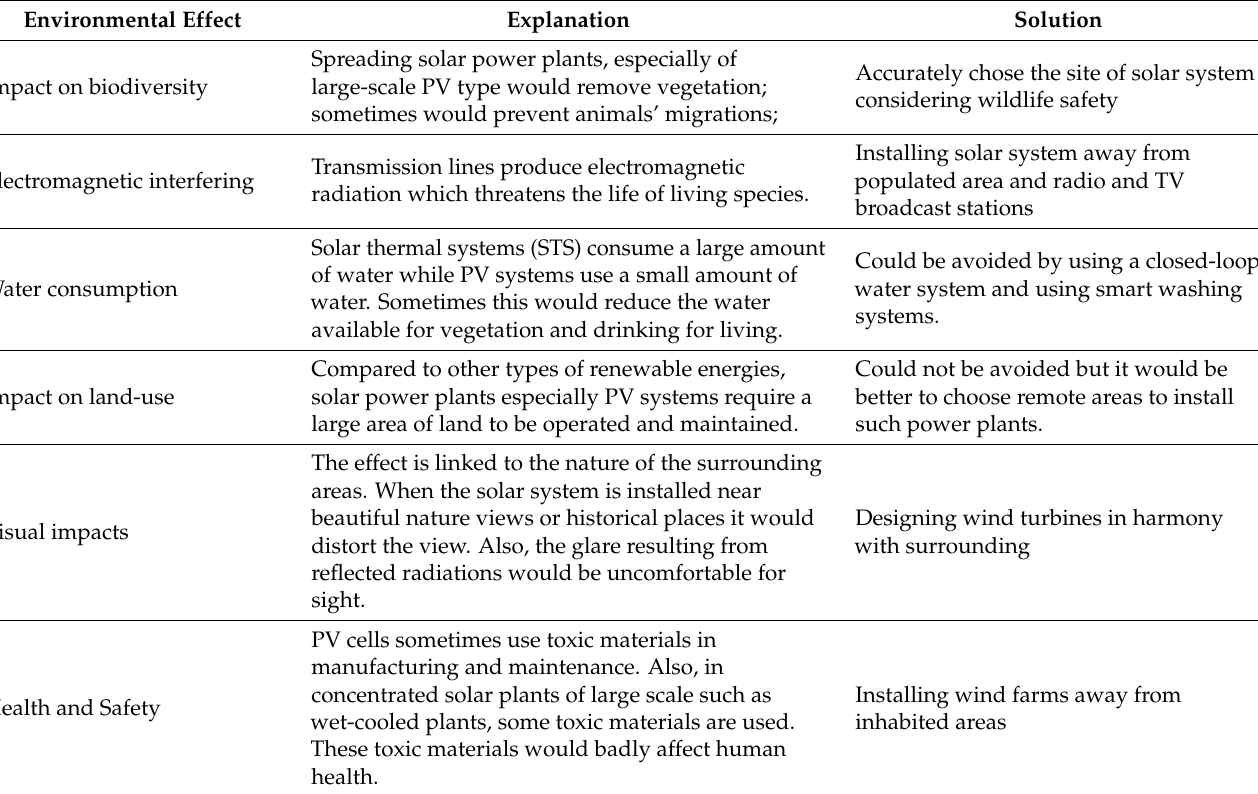
Table 2. Solar power system environmental effect and